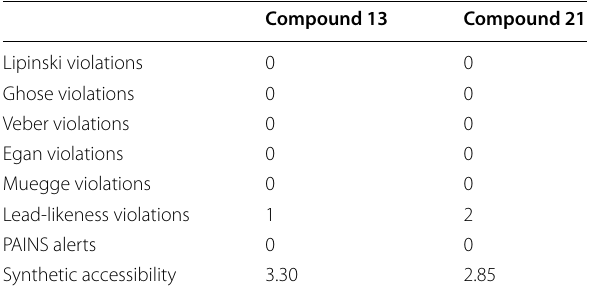
Table 10 Drug-likeness and medicinal chemistry of